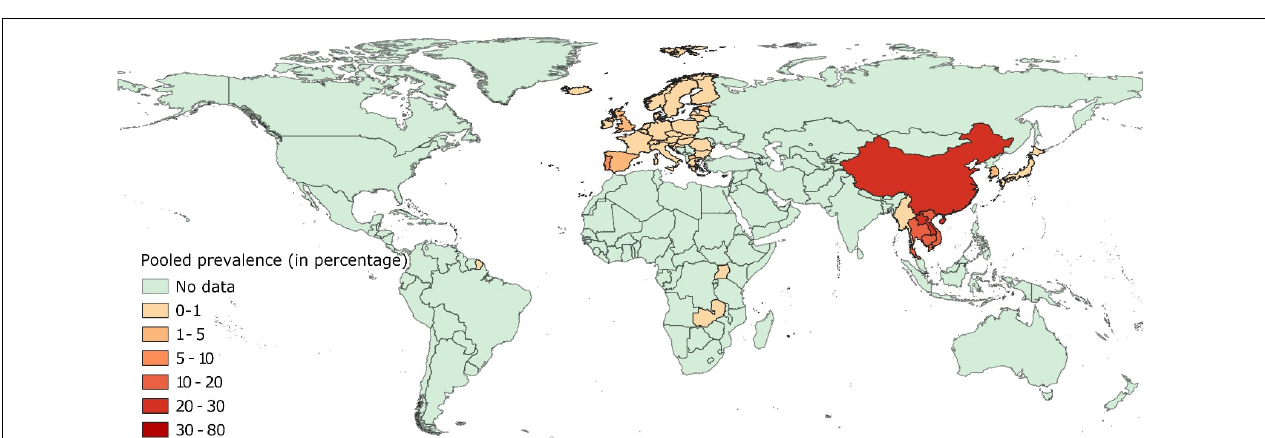
FIGURE 2 | Global distribution of fluoroquinolone resistance in E. coli isolates collected from healthy pigs.